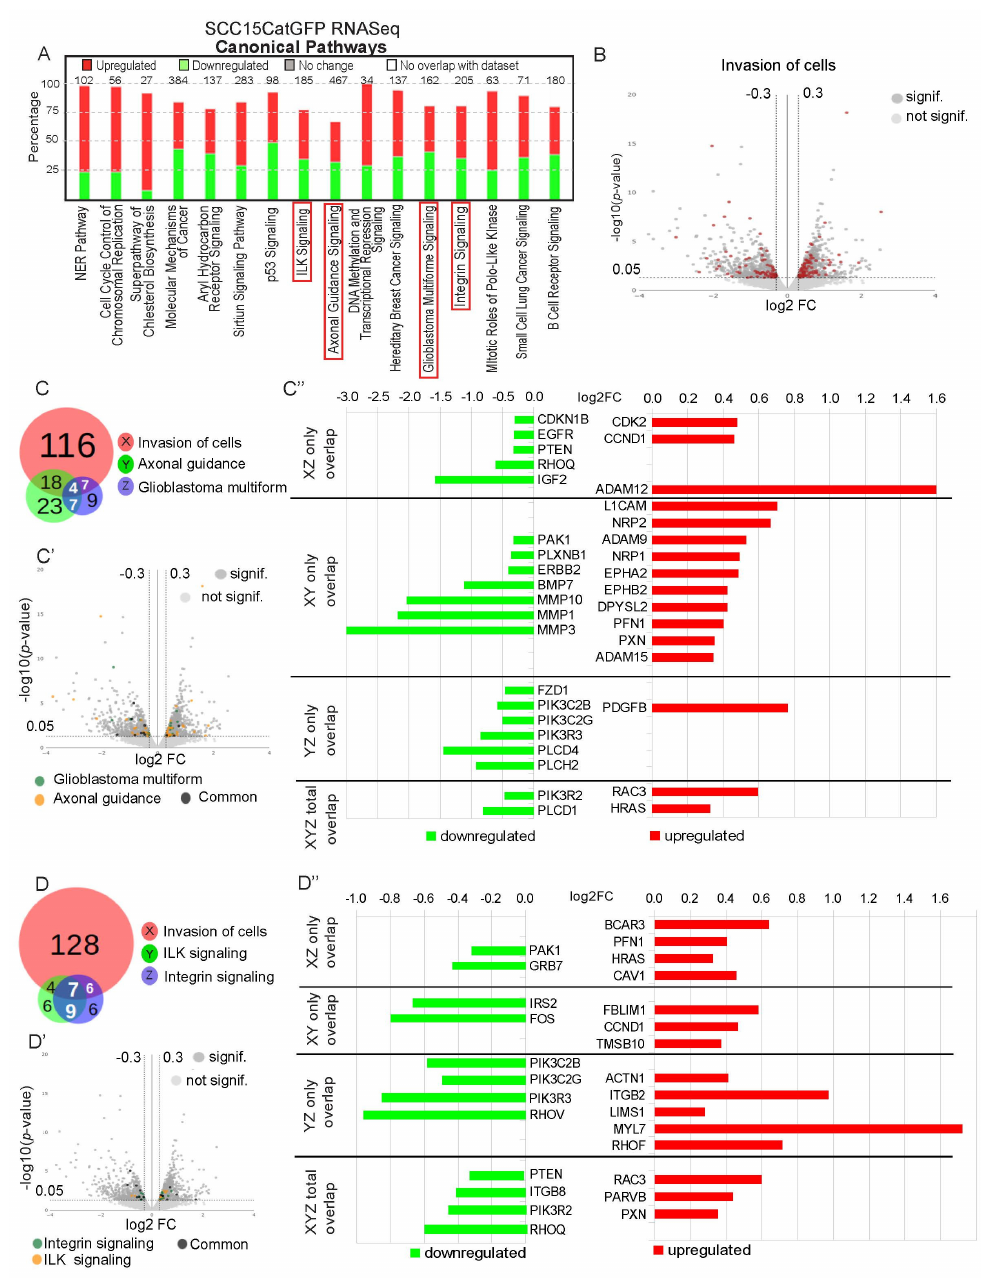
Figure 5. Ingenuity pathway analysis results of RNAseq data of invasive Catulin-GFP reporter-labeled cancer cells. ( A ) Box chart presenting the most changed signaling pathways in the sorted SCC15CatGFP plus population. Signaling pathways of interest are boxed (integrin-linked kinase (ILK), axonal guidance, glioblastoma multiforme, and integrin signaling). ( B ) Volcano plot showing the fold change (log2FC) and statistical significance ( p -value) for all genes differentially expressed in the sorted SCC15CatGFP population. Genes shown in dark grey were statistically significant ( p < 0.05 and log2FC > 0.3), genes shown in light grey were statistically insignificant ( p > 0.05 and log2FC < 0.3), and genes shown in red were significant genes involved in the invasion of cells. ( C ) BioVenn diagram showing the overlap between genes involved in the invasion of cells (X, red), genes related to axonal guidance signaling (Y, green), and genes related to glioblastoma multiforme signaling (Z, violet). The numbers inside the diagram indicated the number of genes in each group. The area of the overlap was proportional to the number of common genes. ( C (cid:48) ) Volcano plot showing the fold changes (log2FC) and statistical significance values ( p -value) for all genes